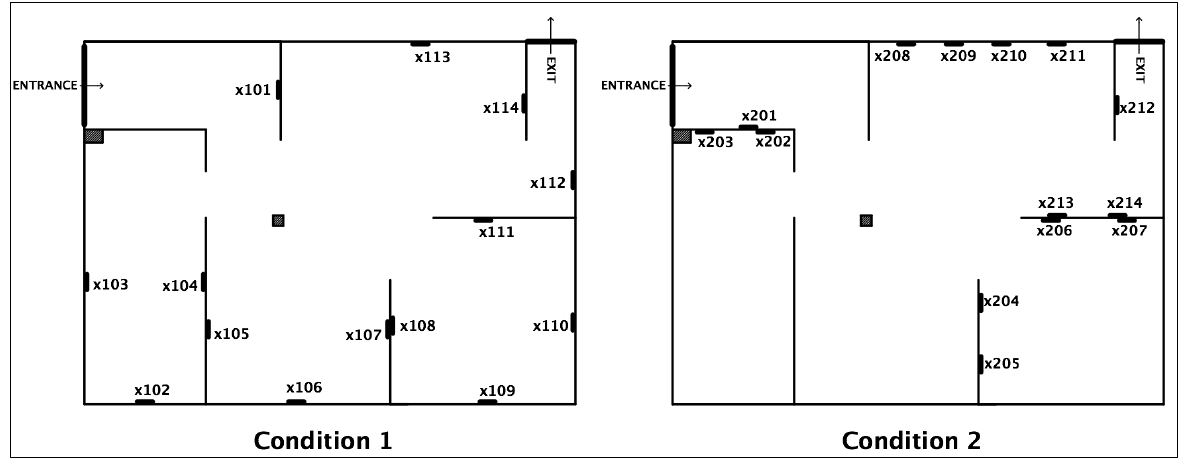
Figure 2. Spatial layout and location names in two experimental